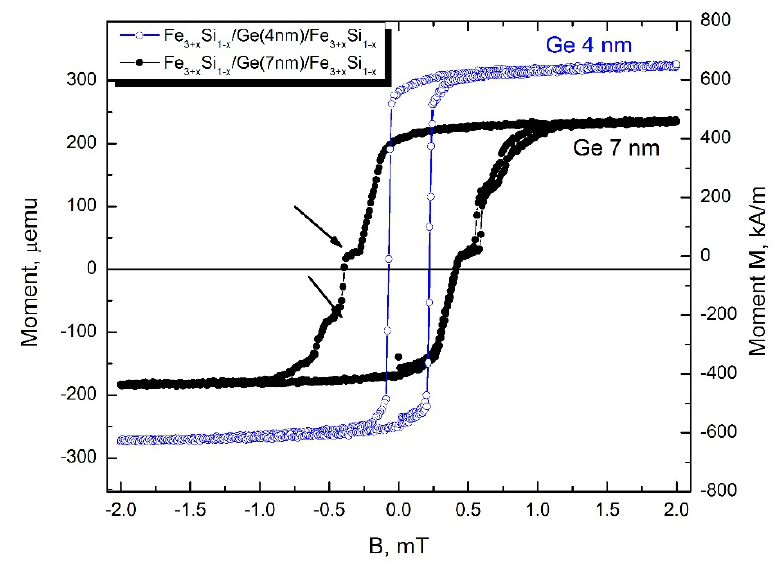
Figure 11. In-plane magnetization reversal of Fe 3+ x Si 1 − x /Ge(4 nm)/Fe 3+ x Si 1 − x and Fe 3+ x Si 1 − x /Ge(8 nm)/Fe 3+ x Si 1 − x structures at 300 K. To determine the magnetic anisotropy, we measured the angular dependence of the ferromagnetic resonance (FMR) spectra both in the plane and perpendicular to the plane at a temperature of 300 K. The spectrum (Figure 12a) for sample #6 “Ge 4 nm” shows two absorption lines, which, given the RHEED and TEM data, most likely correspond to FMR of the upper and lower Fe 3+x Si 1 − x films. For sample #7 “Ge 7 nm” (Figure 12a), the second line is less pronounced and consists of two, potentially three, absorption lines. We ana- lysed the angular dependence of all five lines (Figure 12b–f). The structure has an easy plane magnetization due to shape anisotropy. In addition, polar dependences reveal no magnetic coupling between upper and lower films of iron silicide. In particular, crossing